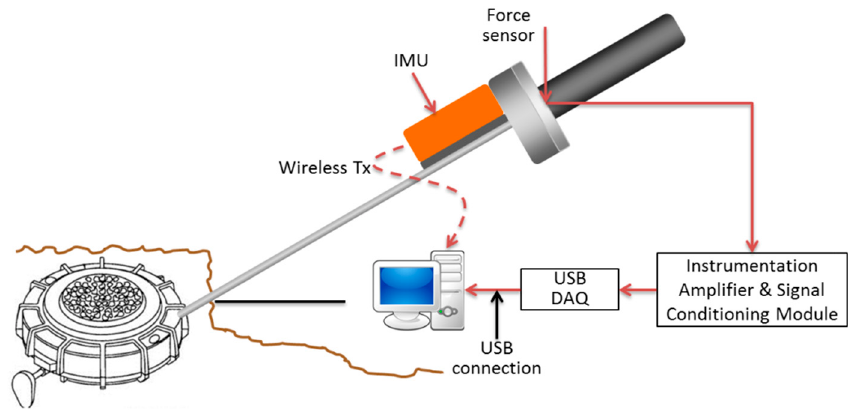
Figure 2. Main components of the proposed tool.